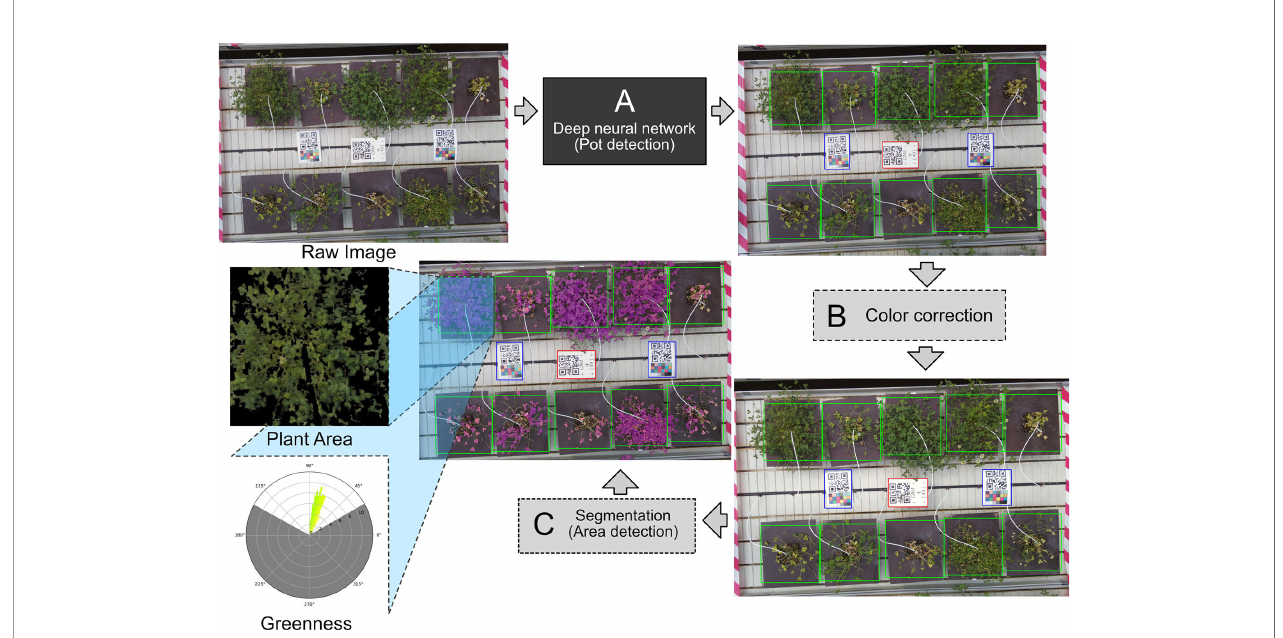
FIGURE 2 | (A) The raw image goes through the deep neural network, which detects the pots on the image. (B) Color correction is applied to the image, using white balance based on the white of the center QR code. (C) When the pots have been identi fi ed, a segmentation algorithm is applied to the image to get area measurements of the plants. Each individual pot is cropped from the image. The plant area and greenness are measured in the cropped image. The greenness is displayed as a circular histogram. The individual crops between the pots are identical in size, making the measurement of area comparable between